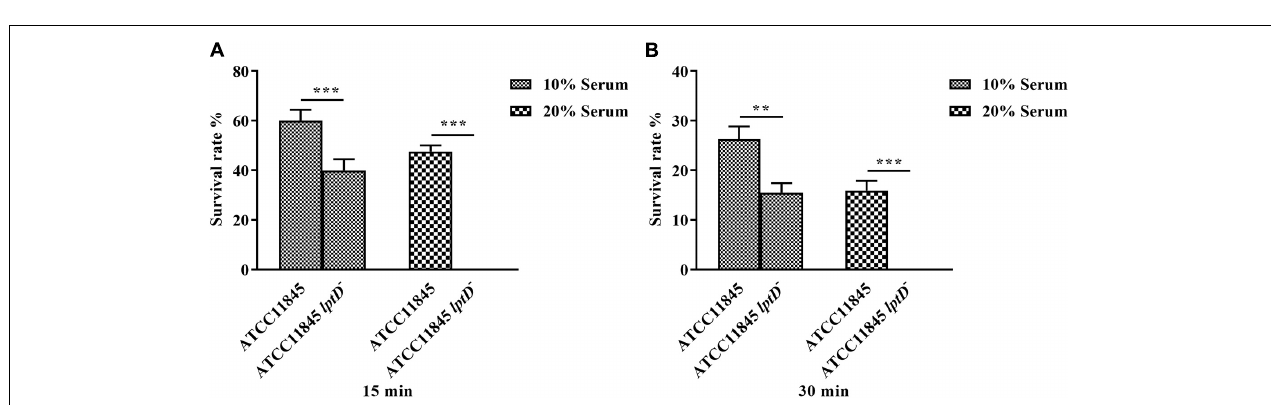
FIGURE 4 | Biofilm formation assay for R. anatipestifer ATCC11845 and ATCC11845 lptD − . (A) Representative images of the results of the crystal violet biofilm formation assay. Strain ATCC11845 (1) and ATCC11845 lptD − (2) were collected from LB agar plates supplemented with 5% sheep blood and resuspended in TSB supplemented with 5% serum at an OD 600 of 0.1 in glass tubes and incubated at 37 ◦ C without shaking for 24 h. Subsequently, the tubes were washed three times with PBS andstained with 6 ml of 0.1% crystal violet for 30 min at room temperature after carefully removing the bacteria. (B) The absorbance of crystal violet-stained biofilm at OD 580 , ∗∗ , p < 0.01.